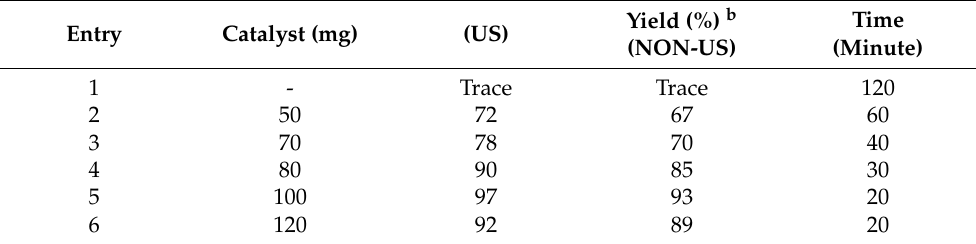
Table 3. Effects of the 1%Pd-HPW/SiO 2 catalyst for the synthesis of the octahydroquinazolinone model ( 4a ) a .